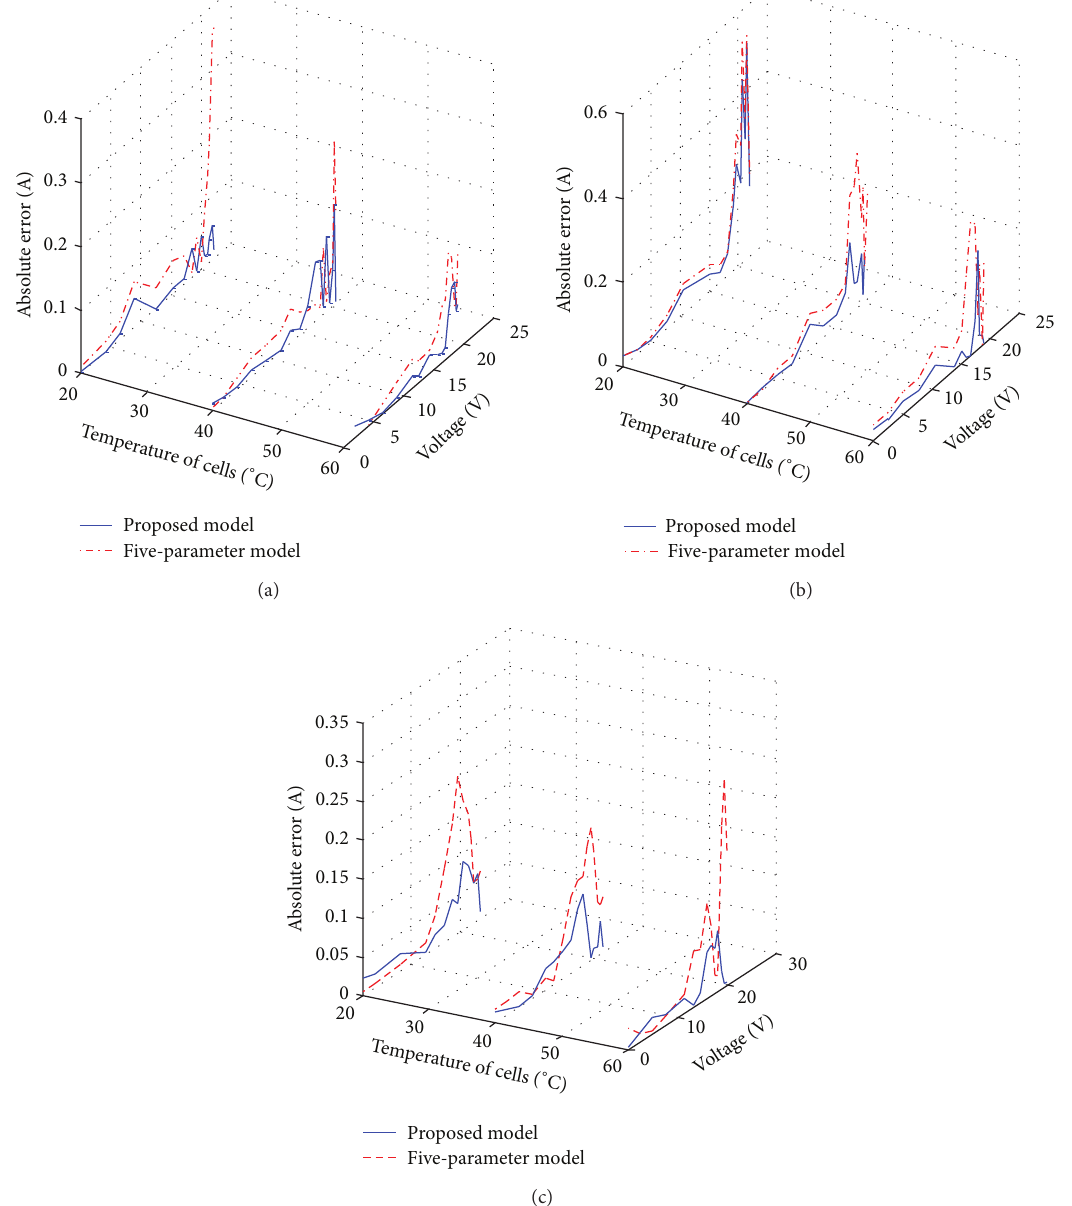
the manufacturers of three PV modules of different